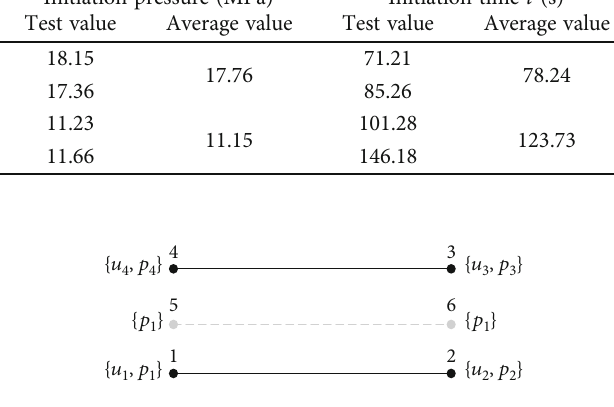
Figure 11: The pore pressure cohesive